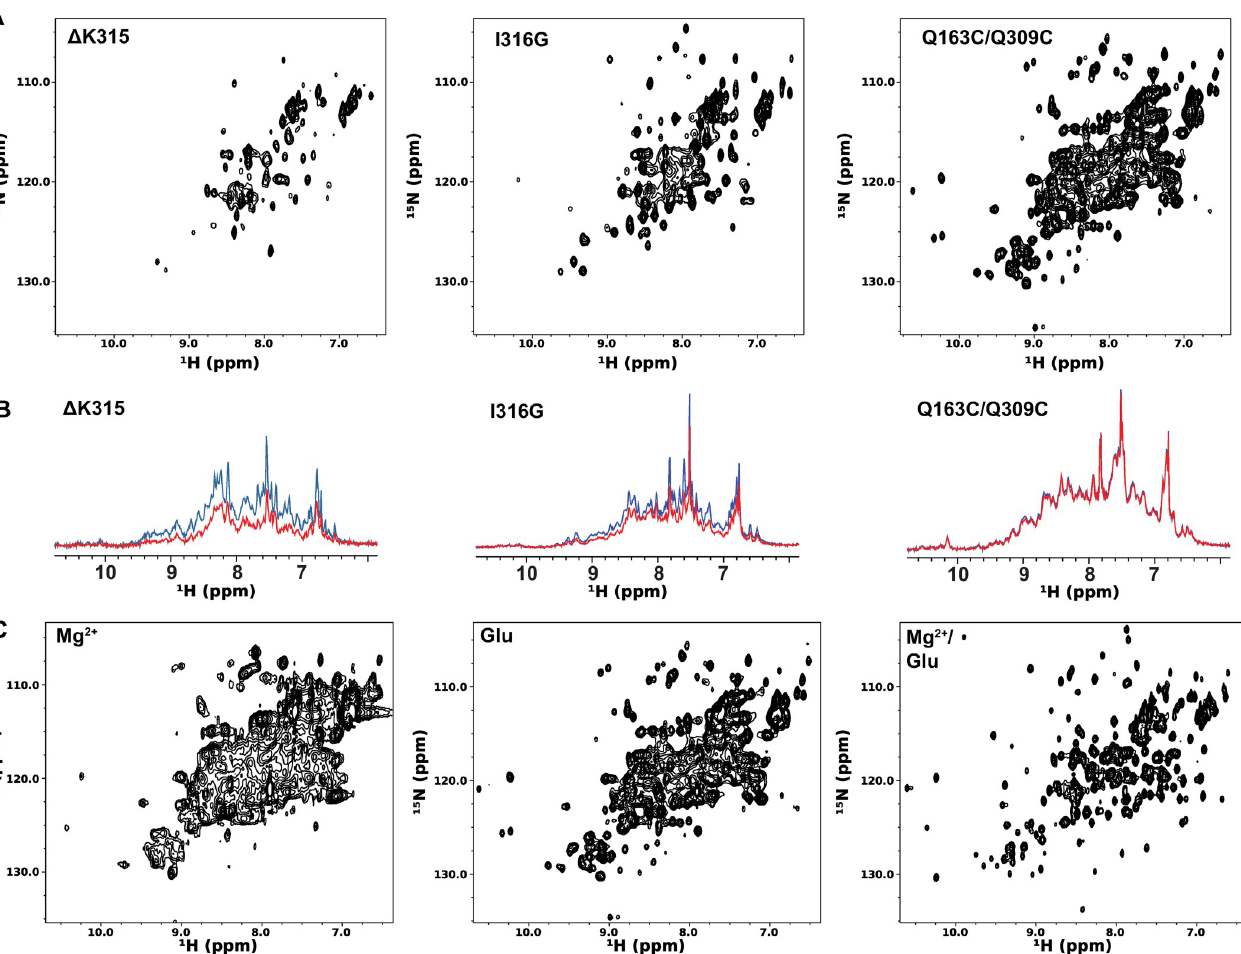
Fig 4. 15 N-edited HSQC spectra of active mutants. A) Comparison of the 15 N-edited HSQC spectra of 0.1 mM Δ K315, I316G, and Q163C/Q309C mutants. Spectra were acquired with identical parameters and displayed at the same contour level. B) 1 st increment of the 15 N-edited HSQC spectra of 0.1 mM Δ K315, I316G, and Q163C/Q309C mutants before (blue) and after (red) a 24-hour incubation at room temperature. C) Effects of 1 mM MgCl 2 and 10 mM sodium glutamate on the spectrum of the Q163C/Q309C